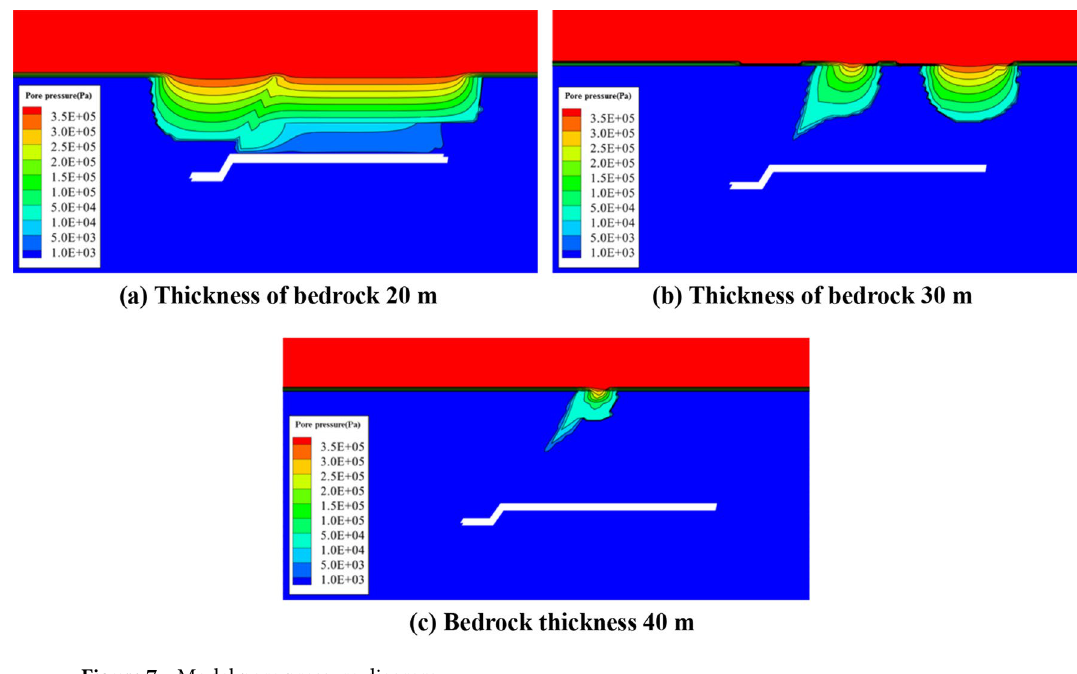
Figure 7. Model pore pressure diagram.